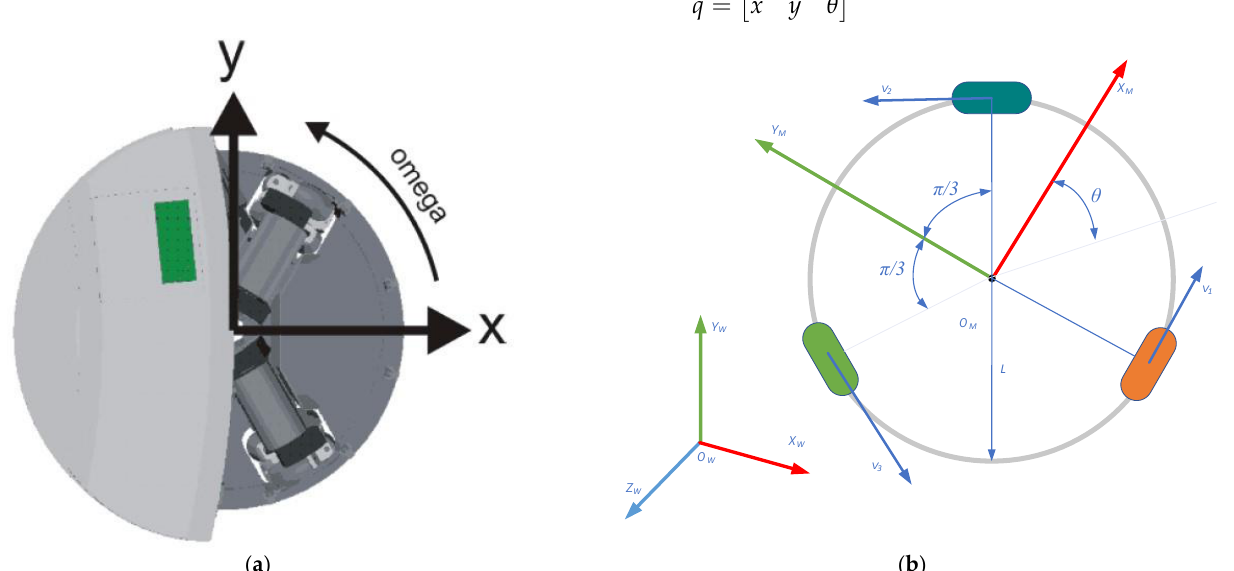
Figure 1. ( a ) Robotino mechanism and ( b ) world and mobile coordinate frames. The moving coordinate frame 𝑉 𝑀 can be expressed with translational velocities and angular velocities as given Equation (2).